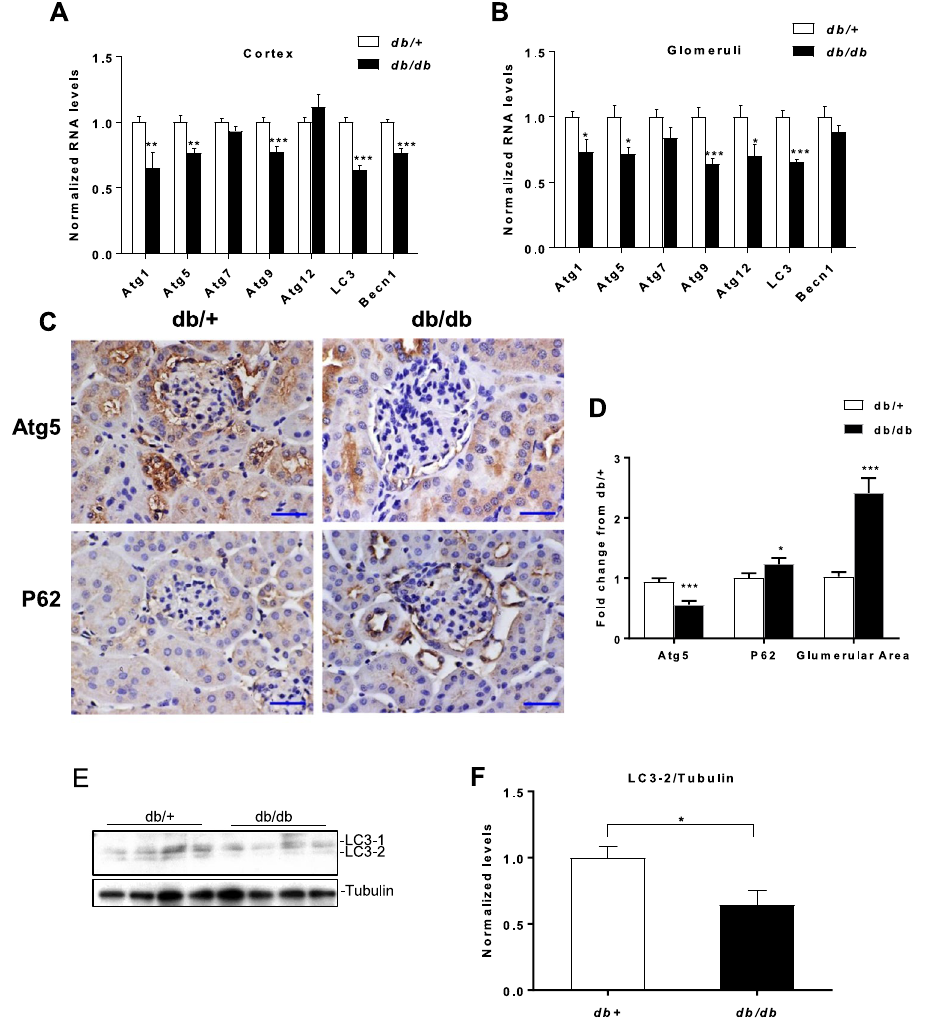
Figure 1. Decreased autophagy gene expression in kidneys of db/db mice relative to control db/ + mice.qRT- PCR analysis of autophagy genes in ( A ) kidney cortex lysates (n = 4 per group) and ( B ) glomerular lysates, from 10–12 week old - db/db mice and db/ + mice (n = 3 per group). ( C ) Representative immunostaining and ( D ) quantification for p62, Atg5 and glomerular area from cortical sections of db/ + and db/db mice; (n = 3 per group). Scale bar, 20 µ m. x400 (10 × 40) magnification. ( E ) Western blot and ( F ) quantification of LC3 levels (LC3-2/Tubulin) from renal glomerular lysates of 10–12-week-old db/ + and db/db mice; (n = 4 per group). Uncropped scans are presented in Supplementary Fig. 1. * P < 0.05; ** P < 0.01; *** P <